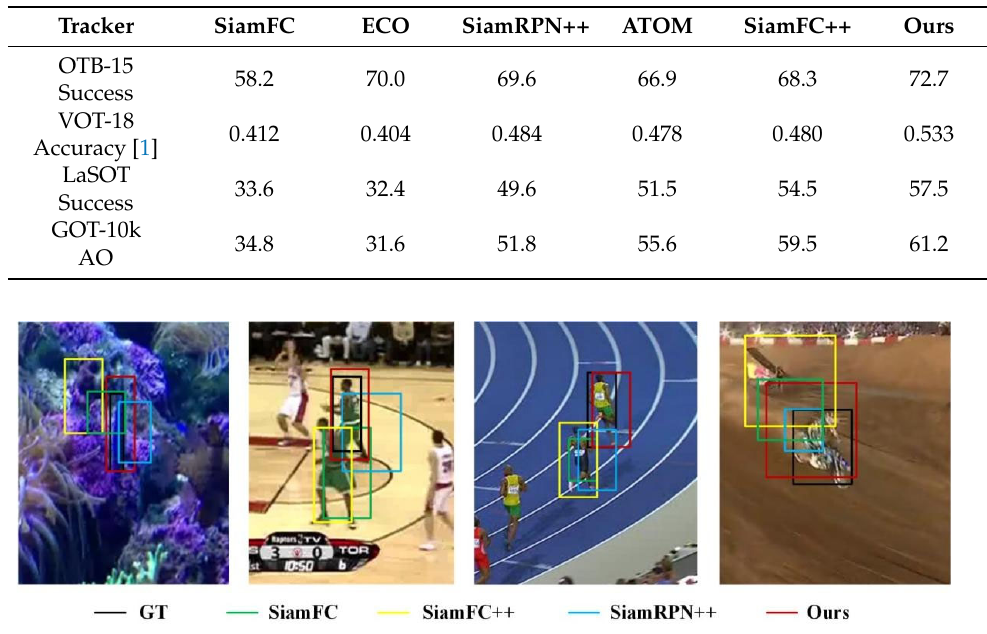
Figure 10. Qualitative comparison results. Table 4. Results on several benchmarks.